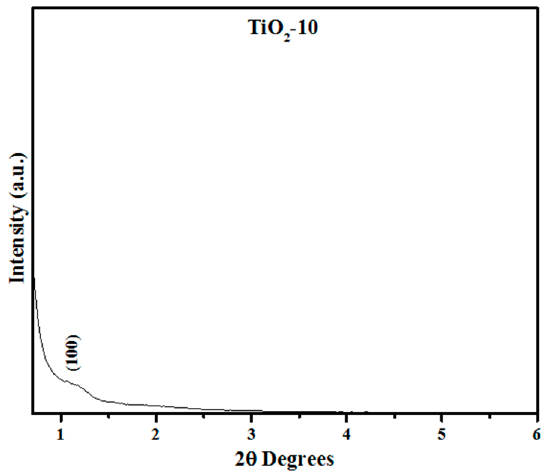
Figure 2. Powder X-ray diffraction of hard templated mesoporous TiO 2 as function of impregnation cycles.